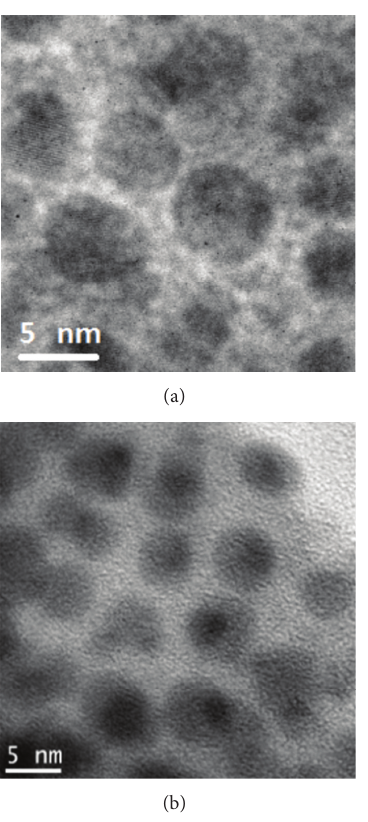
Figure 18: TEM images of Si NPs in Er 3+ doped GeO 2 -Bi 2 O 3 glasses heat-treated during 3 h (a) and during 72 h (b) [5].